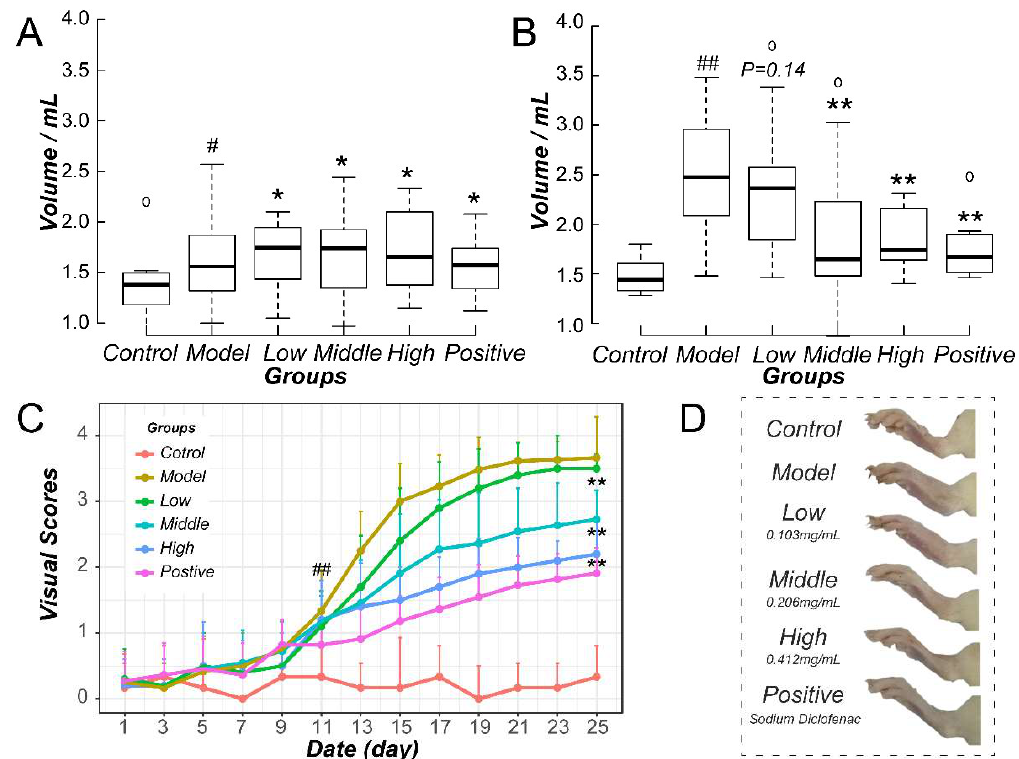
Figure 1. Evaluation on paw swelling of all groups. Swelling volume on Day 11 ( A ) and Day 25 ( B ). ( C ) The visual scores line of all groups including the whole time points. ( D ) The representative swelling states of all groups on Day 25. # p < 0.05 vs. Control. ## p < 0.01 vs. Control. * p < 0.05 vs. Model. ** p < 0.01 vs. Model. The free small circles in ( B ) represent the mild outlier samples.